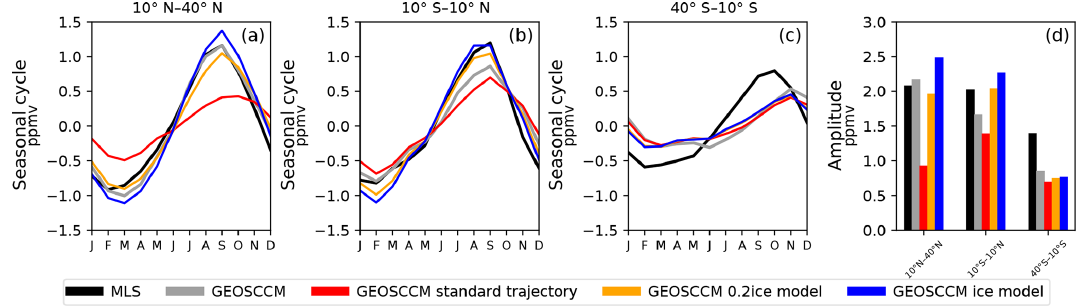
Figure 6. Seasonal cycles of water vapor at 100hPa averaged between (a) 10 and 40 ◦ N, (b) 10 ◦ S and 10 ◦ N, and (c) 40 and 10 ◦ S and their (d) seasonal amplitudes from the GEOSCCM, GEOSCCM standard model, GEOSCCM ice model, and GEOSCCM 0.2ice model. We have subtracted the annual mean from each data